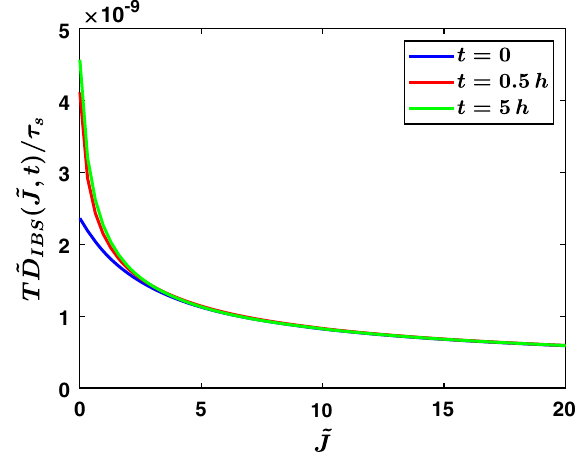
FIG. 5. IBS diffusion term versus the scaled synchrotron action ˜ J at different times (data for the eRHIC parameter set, assuming both cooling and IBS).